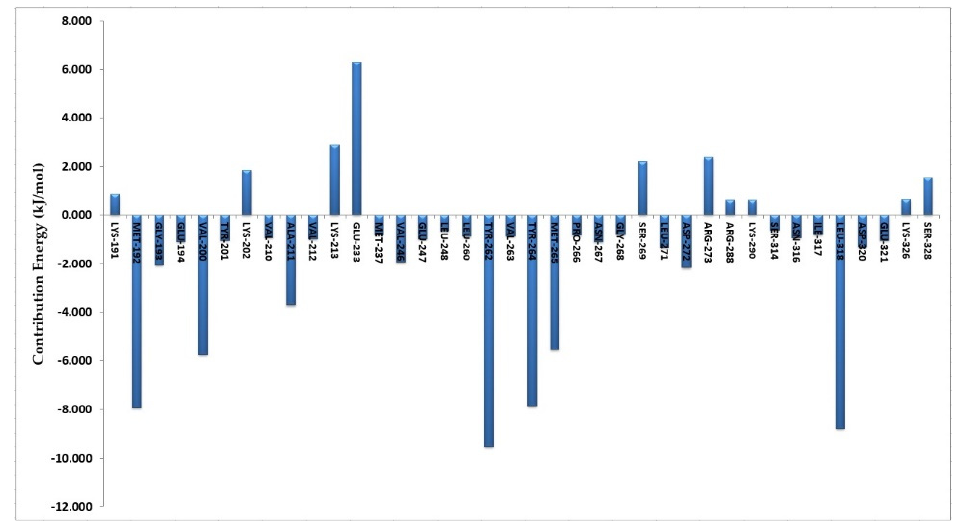
Figure 4. The column chart depicting the each residue contribution in the total binding free energy of compound 33.